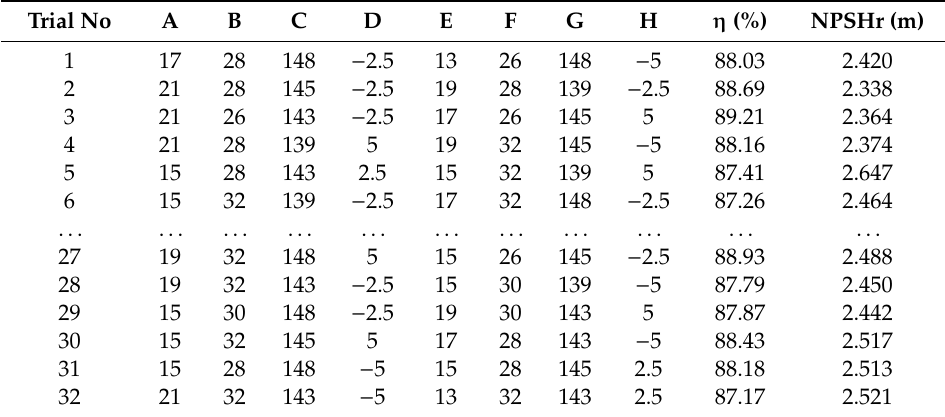
Table 5. Orthogonal scheme